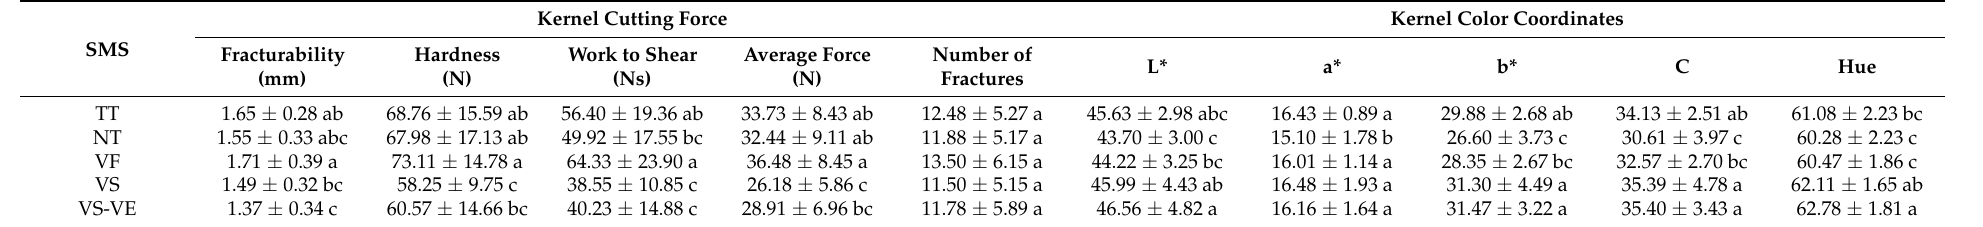
Table 7. Impact of different soil management strategies on texture and color parameters of almonds cv. Marcona.